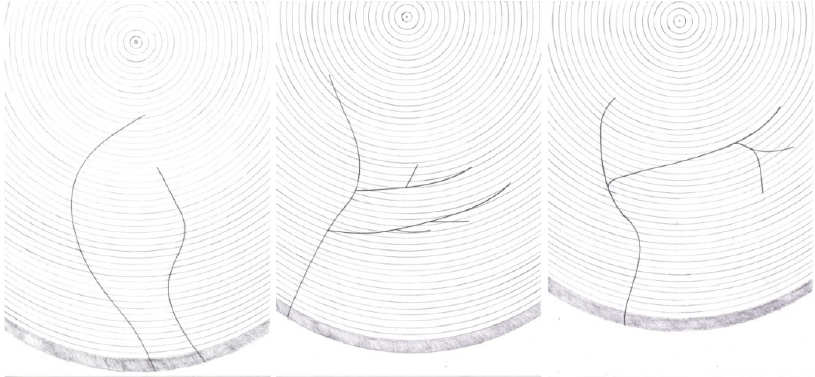
Figure 3. T. oxyurus gallery system: early-, mid- and late-development stages. T. oxyurus did not strictly follow this rule when biting the gallery system; then, the beetle could ascend or descend with slight inclinations. Gallery corridors were slightly winding and mainly were directed towards the centre of the trunk. Some galleries consisted of only one main corridor, but there were also some made up of multiple corridors. In the latter case, the side corridors branched off from the central corridor, directed towards the centre of the trunk. The range of angles at which the corridors branched extended from could approximately follow the line of the growth rings and slightly intersect it. The third option was to turn back towards the bark of the tree. In addition, side branches of the corridor could be separated again (Figure 3). The corridor systems of this beetle always branched out in the direction from the entrance to the interior. In the opposite direction, towards the surface of the trunk, the corridors did not fork. Galleries had only one en ‐ trance; no two or more entrances would merge into one gallery.